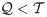
Empirical CDFs for the DERS parameter sets within the blue cluster for those cij significantly different.This ensemble has been generated according to the methodology explained in Section ER-system ensemble generation and parameter sensitivity analysis (see also [16]). The DERSs within the blue cluster have been divided into two subsets: those such that Q<T (SC-locked, blue lines) and those such that Q≥T (non-SC-locked, orange lines), with T = 0.7. For comparison, we plot the CDFs of the whole DERS ensemble (magenta lines), and, for guidance the CDF corresponding to a uniformly distributed random variable (black lines).